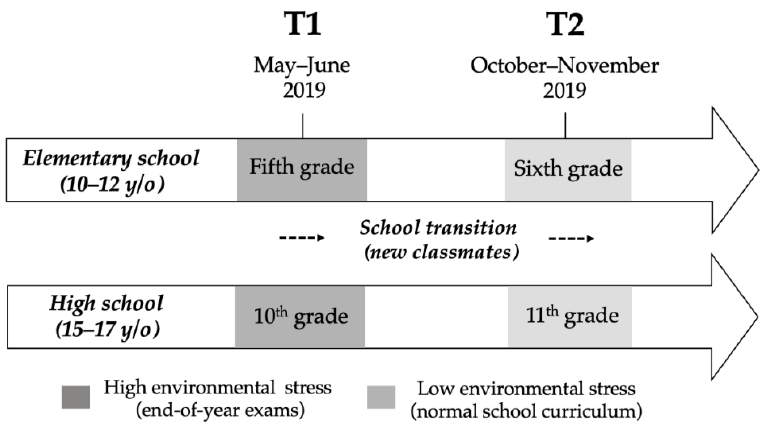
Figure 1. Schematic representation of the original study design conducted by A-A. Journault et al. Elementary school students were followed from Grade 5 (T1) to Grade 6 (T2) and high school students were followed from Grade 10 (T1) to Grade 11 (T2). For both elementary and high school students, T1 occurred at the end of the school year (May and June 2019), which was characterized as a high environmental stress period. T2 occurred at the beginning of the next school year (October and November 2019), during the normal school curriculum, which was characterized as a period of low environmental